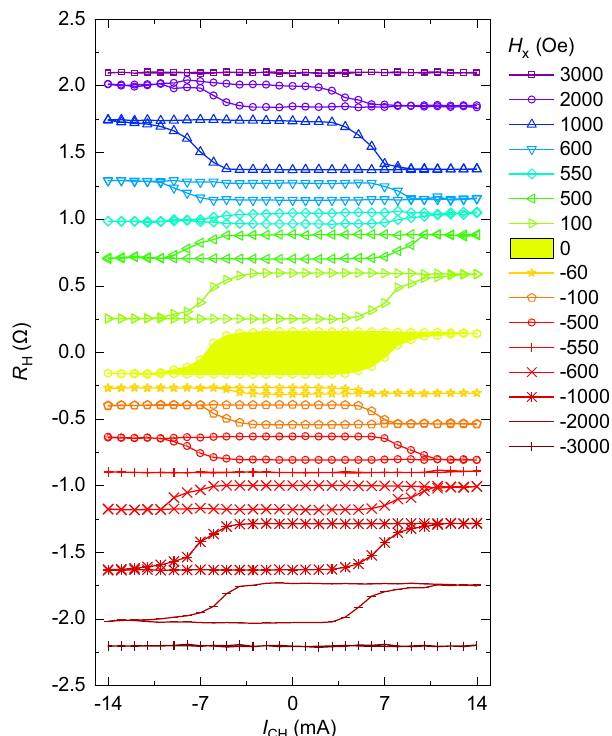
Fig. 4 Field-free SOT switching based on exchange bias and interlayer exchange coupling. The R H – I CH loops measured under various in-plane magnetic fi elds H x ranging from − 3000Oe to 3000Oe for the IrMn/Co/ Ru/CoPt